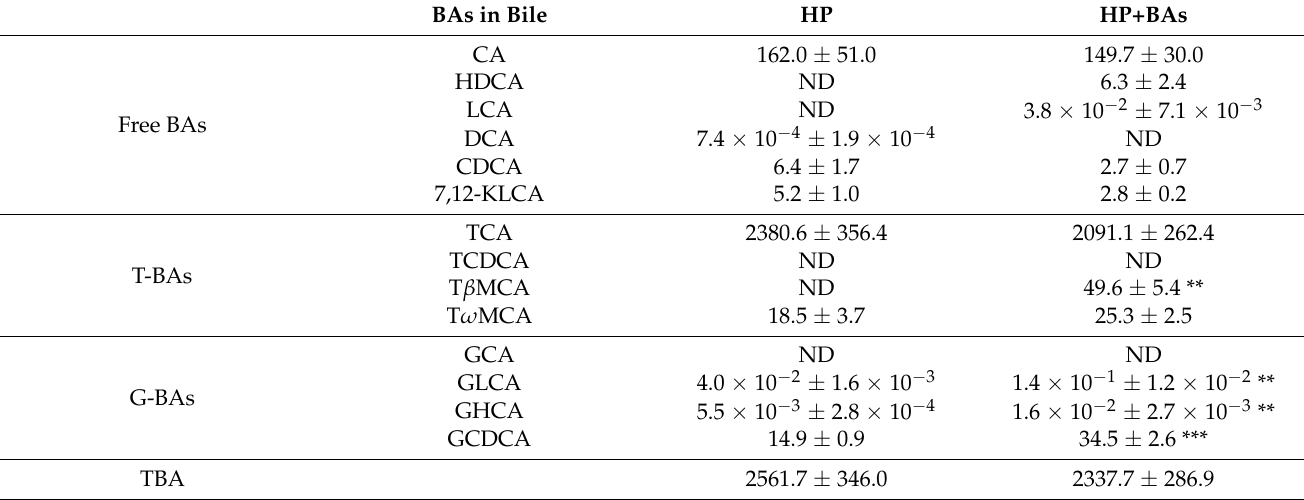
Table 4. Bile acid profile in bile of common carp in HP and HP+BAs groups ( µ mol/L), T β MCA, GLCA, GHCA, and GCDCA increased observably in the HP+BAs group carp bile. Data are shown as mean ± SEM ( n = 7). Statistically significant results are indicated by asterisks (**, p < 0.01; ***, p < 0.001).